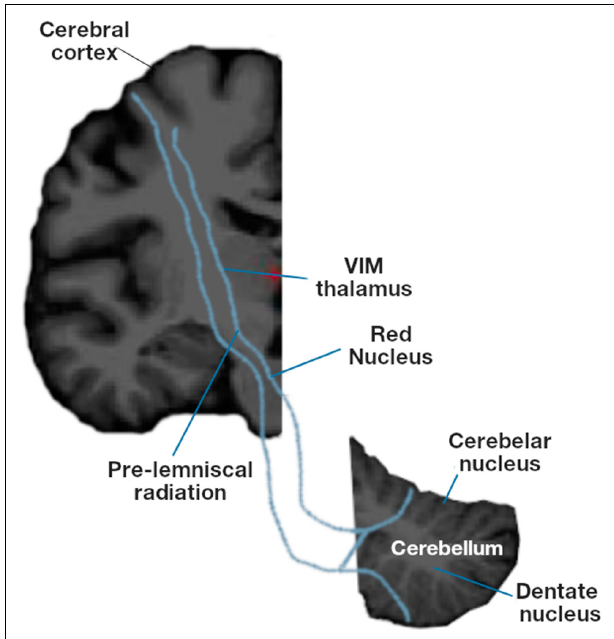
FIGURE 2 | Motor circuit involved in essential tremor: subcortical areas (cerebellum, thalamus and basal ganglia), white matter (cerebellar and cerebellum), motor and premotor cortices.